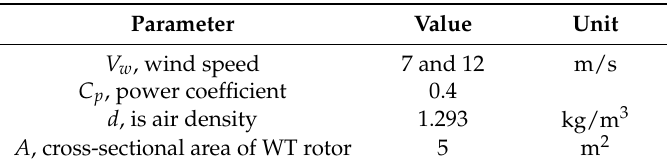
Table A2. Values of various parameters of wind